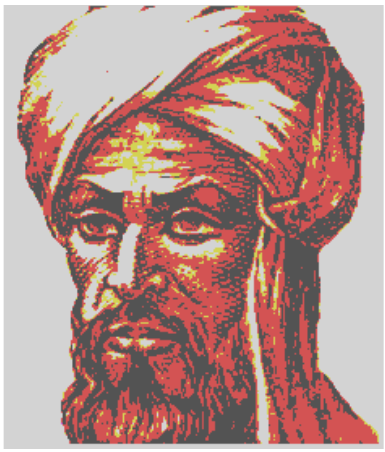
Figure 33. Khwarizmi using GMM.